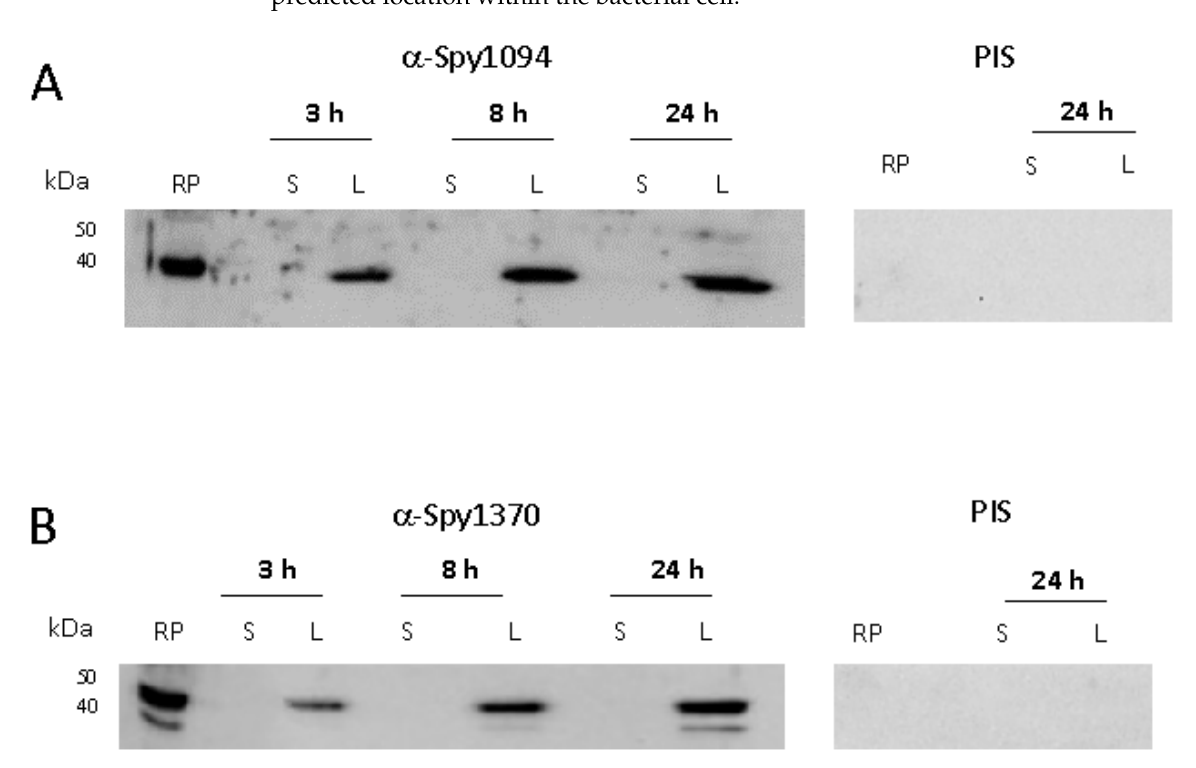
Figure 3. Expression of Spy1094 and Spy1370 during in vitro bacterial growth. S. pyogenes strain SF370 (serotype M1) was grown in BHI broth for 3 h (OD 600 = 0.4), 8 h (OD 600 = 1.1) and 24 h (OD 600 = 1.2) at 37 °C without shaking. Sonicated bacterial lysate (L) and cell culture supernatant (S) were analysed by Western blot using specific antibodies raised against the purified recombinant proteins in rabbits; 2 μ g of recombinant protein (RP) was loaded as a control. PIS, pre-immune serum. ( A ) Spy1094. ( B ) Spy1370.